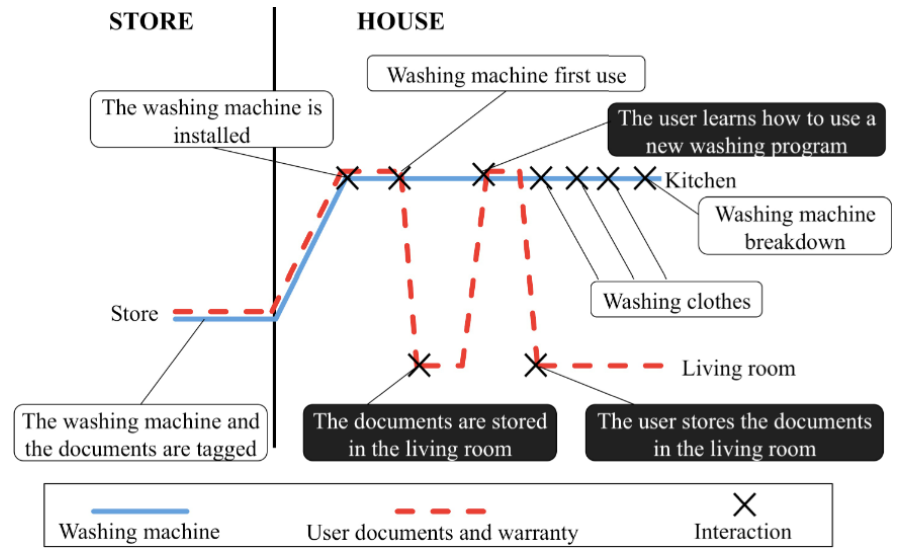
Figure 5. Lifeline of the Washing machine and its